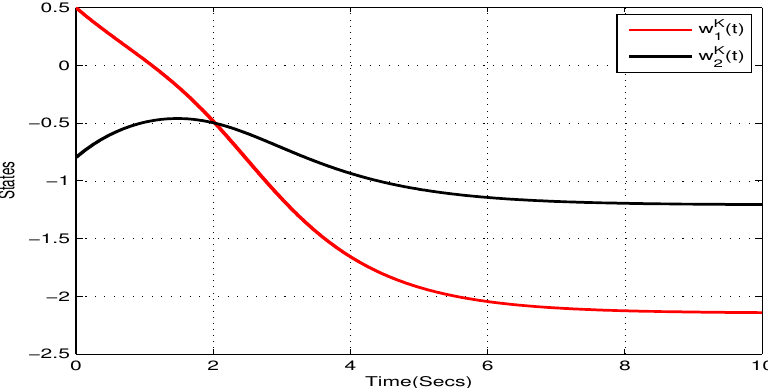
( t ) , w K ( t ) of systems (23) with state feedback control u 2 1